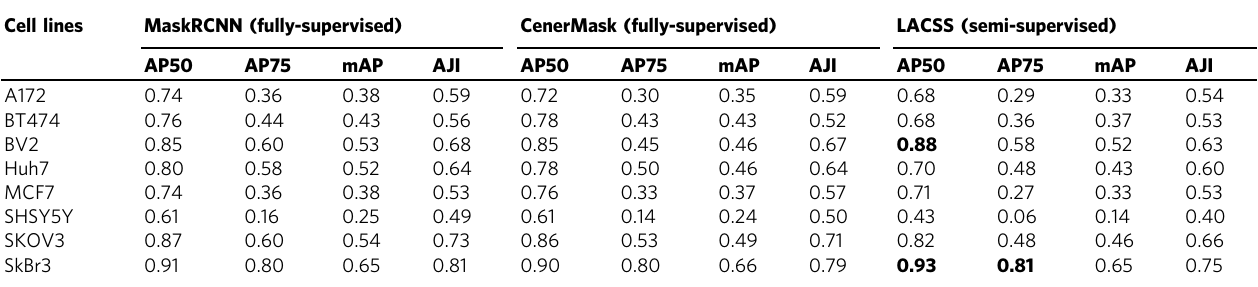
Table 1 Comparison of LACSS model and the baselines on the LIVECell dataset. Cell lines MaskRCNN (fully-supervised) CenerMask (fully-supervised)